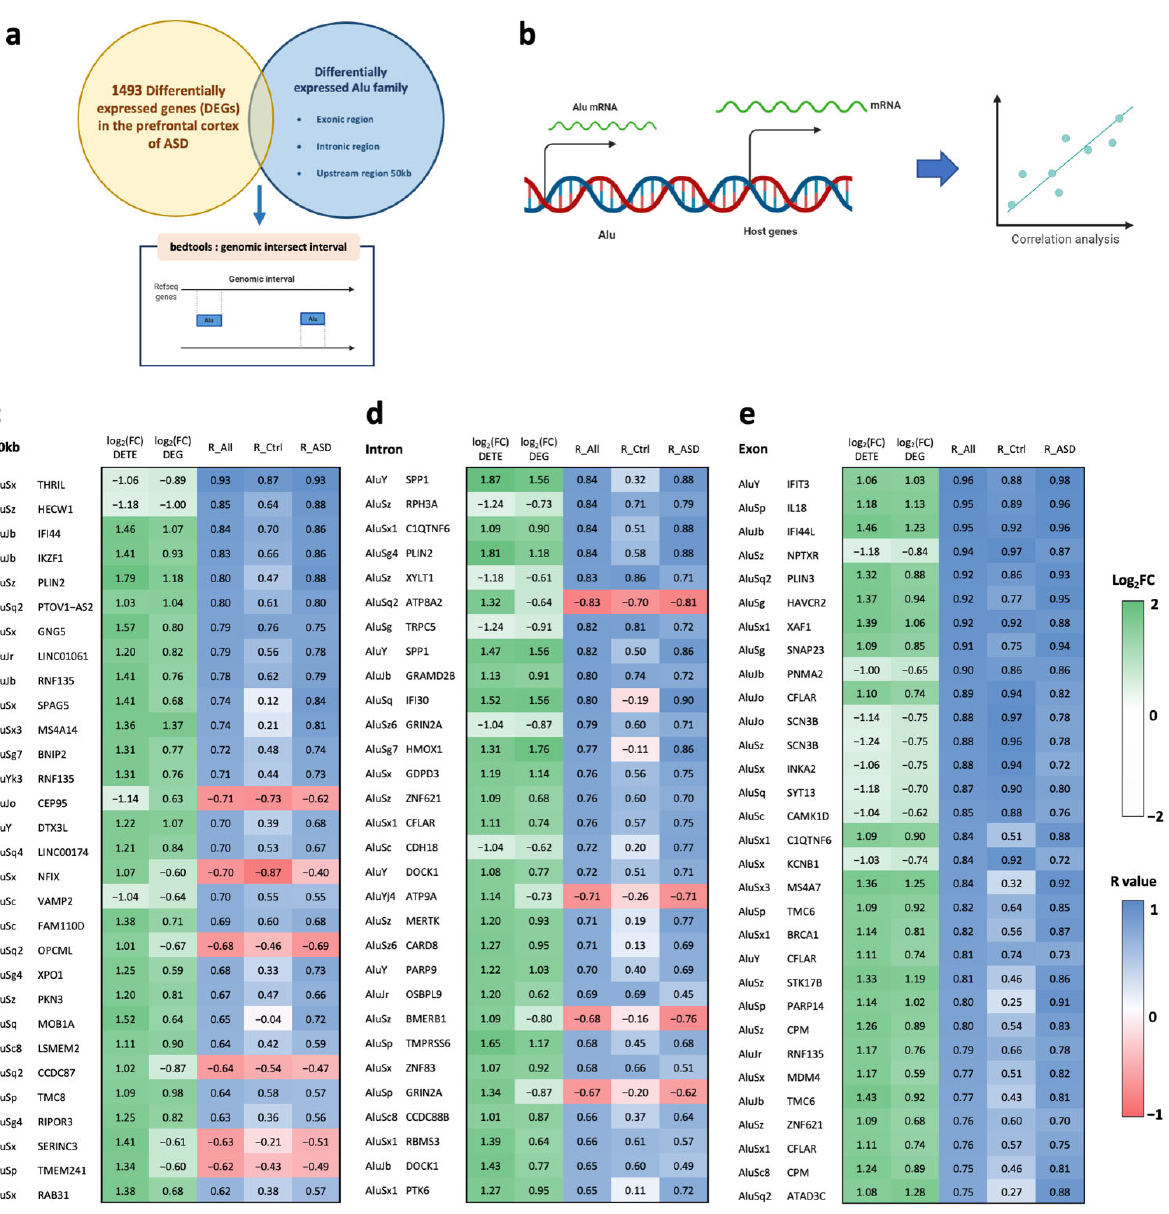
Figure 3. Correlation between differentially expressed Alu family members and their host DEGs in the prefrontal cortex of ASD individuals: ( a ) The intersection of genomic intervals between DE Alu and DEGs to identify host DEGs of individual DE-Alu elements classified into 50 kb upstream regions, intronic regions, and exonic regions created with BioRender.com (accessed on 4 January 2023). ( b ) Illustration of dysregulation of the Alu family affecting host/nearby gene expression created with BioRender.com (accessed on 4 January 2023). Heatmap (log 2 FC and R-value) of the top 30 DEGs most significantly correlated with the Alu family, as classified into 50 kb upstream ( c ), intronic ( d ), and exonic ( e ) regions.